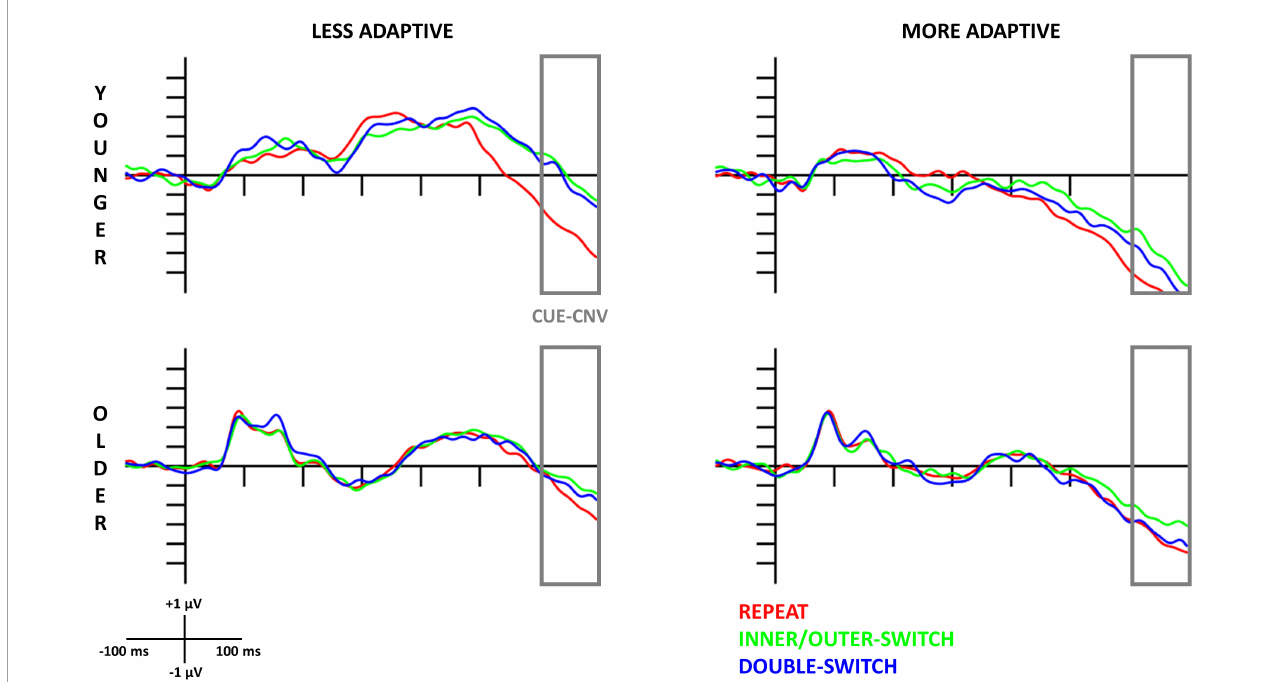
FIGURE2 Cue-locked contingent negative variation (CNV) component at the Cz electrode site for each Switch-type in the adaptive creativity groups. The gray rectangles show the time window (600–700 ms) where the amplitude averages were calculated. The 0 ms time point on the x -axis is locked to the cue (letter combination)